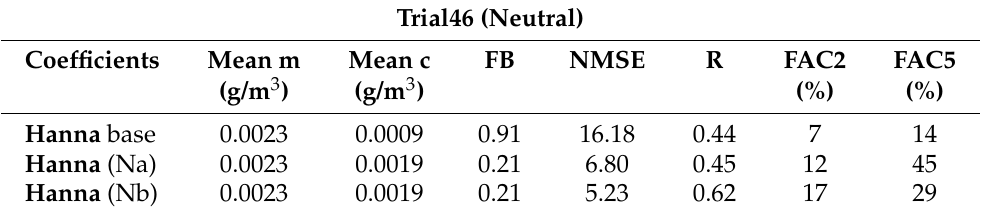
Table 3. Statistical analysis for the mean concentrations in the neutral case trial 46. m indicates measured and c